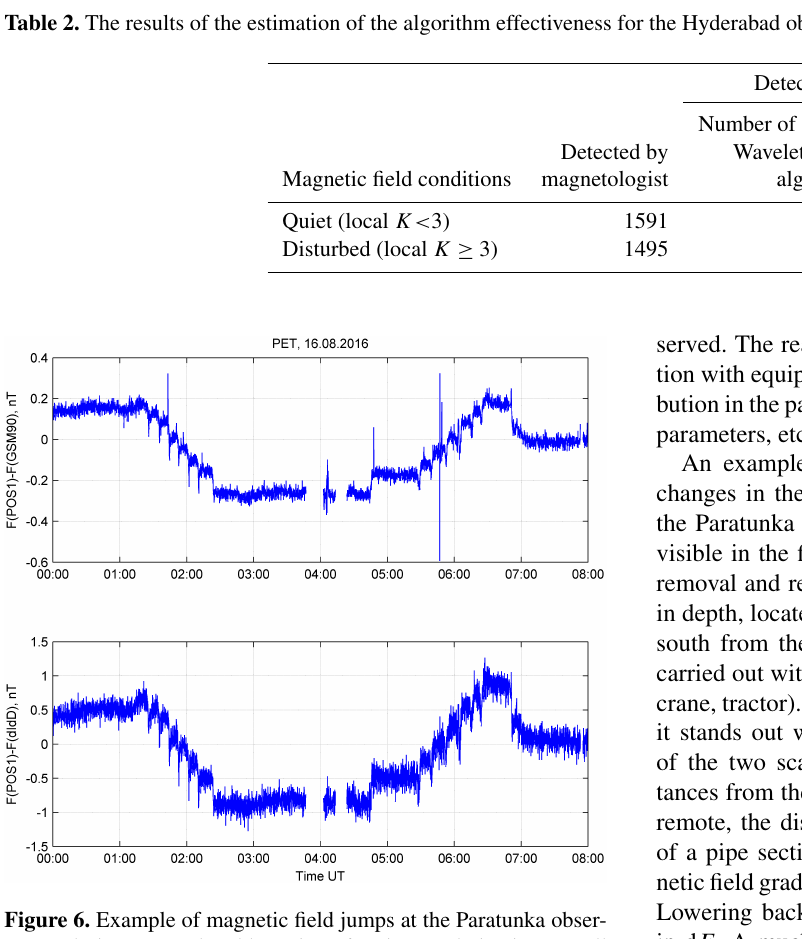
Figure 6. Example of magnetic field jumps at the Paratunka obser- vatory during removal and lowering of casing steel pipe into a well of 80m depth. Curves on the plots are differences of field total in- tensity F measured by scalar magnetometers POS-1, GSM-90 and dIdD at various distances from the well. Each step corresponds to the operation with one pipe